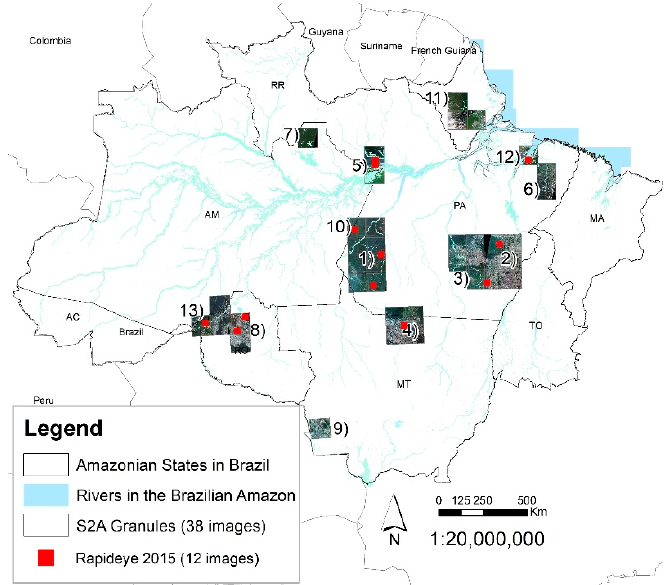
Figure 1. Thirteen mining regions in the Brazilian Amazon evaluated in this study: (1) Tapajós River; (2) Carajás; (3) Rio Xingu; (4) Peixoto de Azevedo; (5) Trombetas/Juruti; (6) Capim River; (7) Mina Taboca; (8) Ariquemes; (9) Pontes e Lacerda; (10) Amanã River; (11) Amapá; (12) Barcarena; (13) Madeira River. Indication of 38 Sentinel-2A images used for mapping mining areas and 12 RapidEye images used for validation purposes. Federal States within the Amazon region: Acre (AC), Amapá (AP), Amazonas (AM), Maranhão (MA), Mato Grosso (MT), Pará (PA), Rondônia (RO), Roraima (RR), and Tocantins (TO).